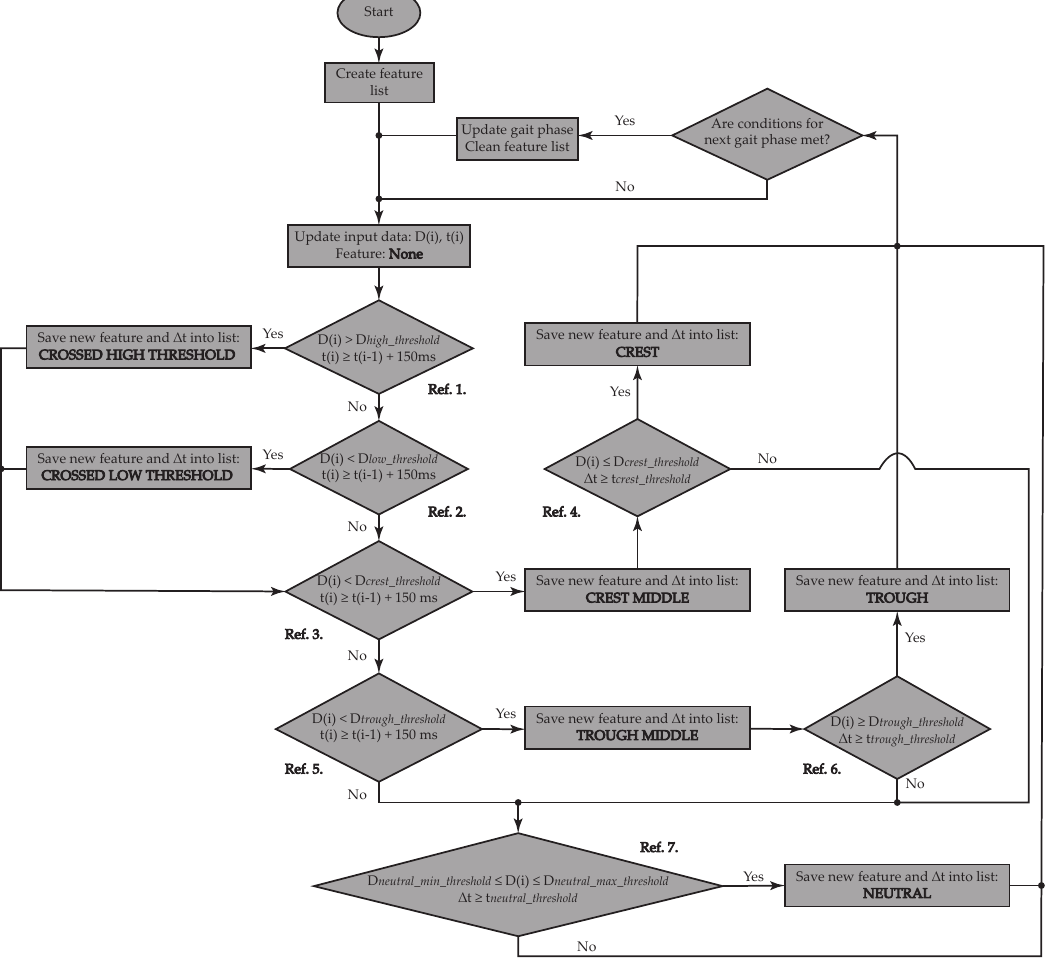
Figure 1. Flowchart of feature extraction from inertial motion data. This chart shows how a feature list is updated based on the fulfilment of certain conditions. The occurrence of each feature and their corresponding conditions are sequentially assessed in the following manner: Crossed High Threshold (Ref. 1), Crossed Low Threshold (Ref. 2), Crest Middle (Ref. 3), Crest (Ref. 4), Trough Middle (Ref. 5), Trough (Ref. 6), and Neutral (Ref. 7). When a new gait phase is detected, the feature list is emptied for further